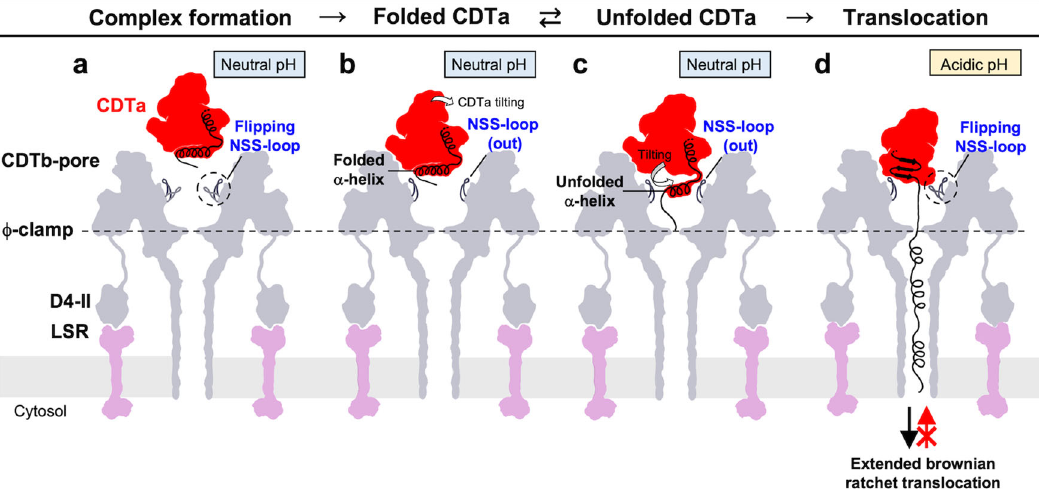
Fig. 7 | Modelfor translocationofCDTa. Theillustratedprotomersof CDTb-pore are equivalent to subunits C (left) and F (right). a CDTb-pore beforeCDTabinding. NSS-loops are shown in ‘ in ’ and ‘ out ’ states. b Single CDTa bound to CDTb-pore.